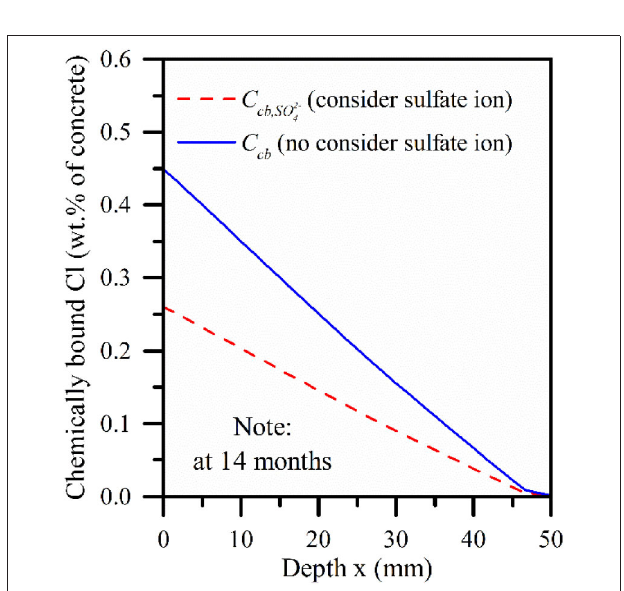
FIGURE 11 | Free chloride concentration under different initial water-cement ratio.